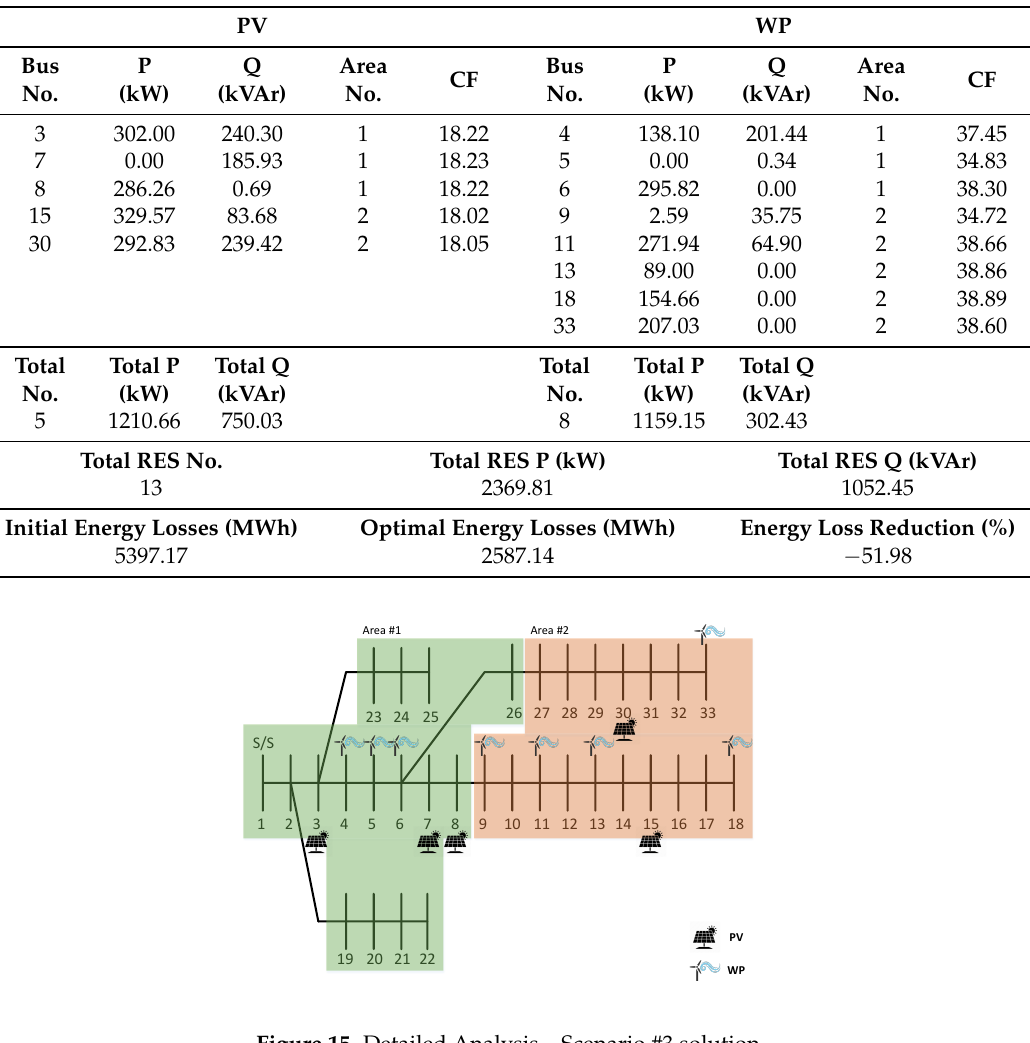
Figure 14. Detailed Analysis—Scenario #2 solution. Table 10. Detailed Analysis—Scenario #3.